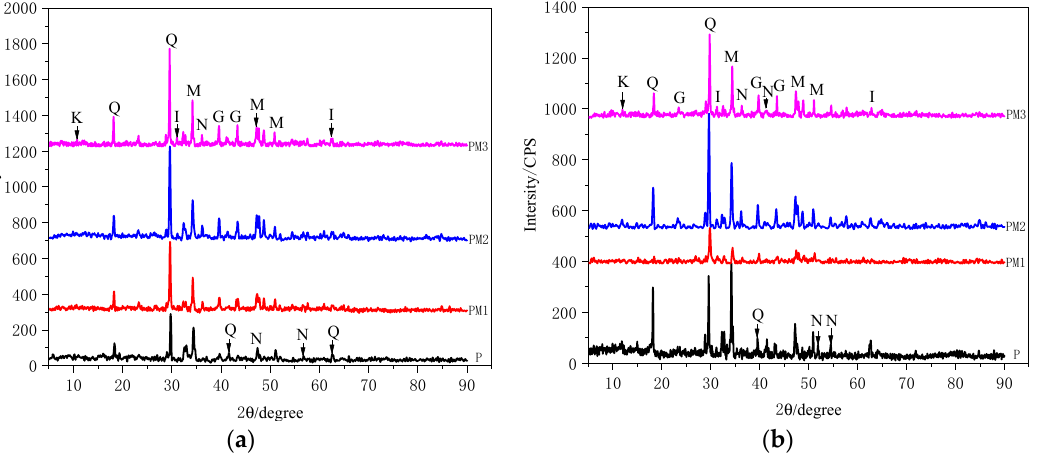
Figure 14. Comparison of the 3 d and 28 d XRD of Samples. ( a ) 3 d XRD of Samples. ( b ) 28 d XRD of Samples. Q: C-S-H. M: Ca(OH) 2 . N: C 3 S + C 2 S. G: CaCO 3 . K: C 3 A·CaCO 3 ·11H 2 O. I: C 3 AH.